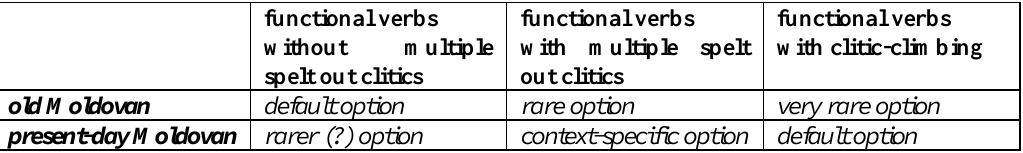
Table 5. Changes in the structure of Moldovan predicates containing infinitives functional verbs functional verbs functional verbs without multiple with multiple spelt with clitic-climbing spelt out clitics out clitics old Moldovan default option rare option very rare option present-day Moldovan rarer (?) option context-specific option default